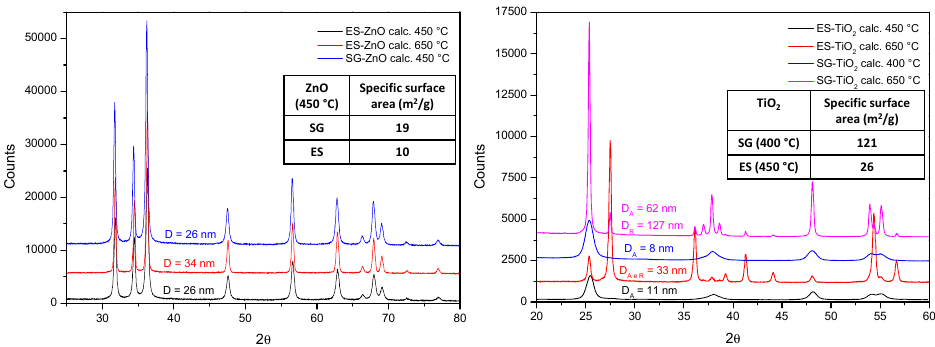
Figure 1. X-ray diffraction patterns for all synthesized powders; in the insets the specific surface areas.